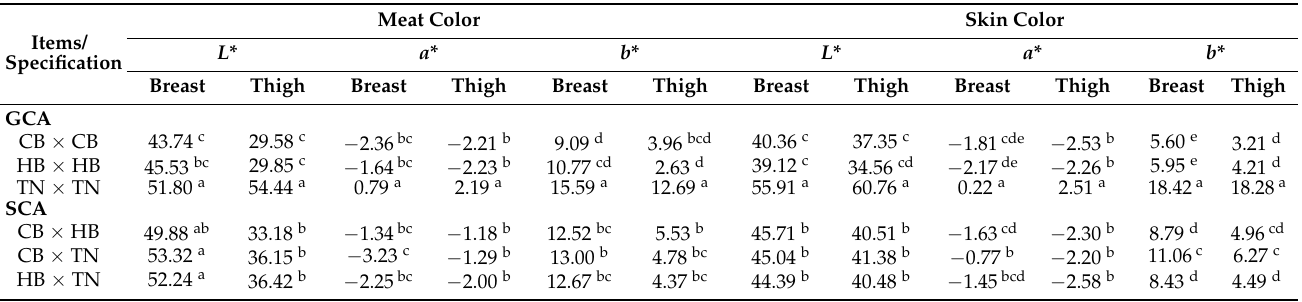
Table 4. The meat and skin color of the breast and thigh parts in black-bone chickens, Thai native chickens, and their